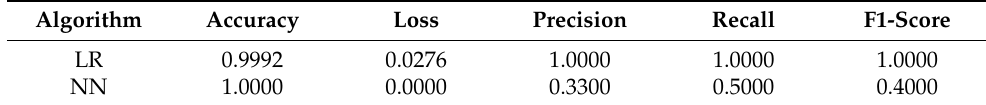
Table 4. Algorithms’ results using the up-sampled dataset as input. Algorithm